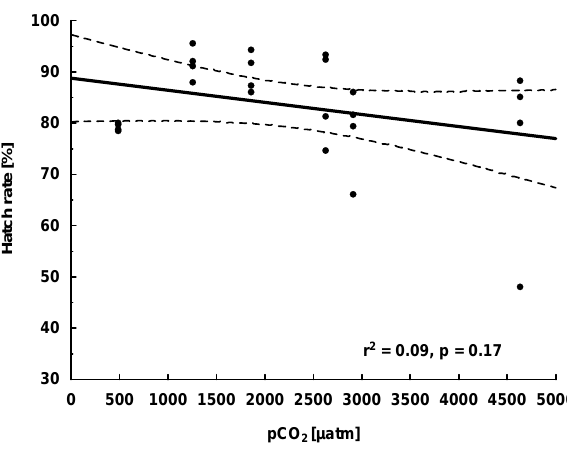
Fig. 2. Hatch rate (%) of Atlantic herring eggs as a function of p CO 2 (4 replicates per treatment level). Data points are percentages Figure 2. Hatch rate (%) of Atlantic herring eggs as a function of pCO 2 (4 replicates per treatment of hatched larvae of incubation plate 1 of the respective replicate. The solid line shows the regression line, whereas the dashed lines level). Data points are percentages of hatched larvae of incubation plate 1 of the respective replicate. represent the 95% confidence intervals. The r 2 and P -value were The solid line shows the regression line, whereas the dashed lines represent the 95% confidence derived from arcsine transformed intervals. The r 2 and P -value were derived from arcsine transformed data.